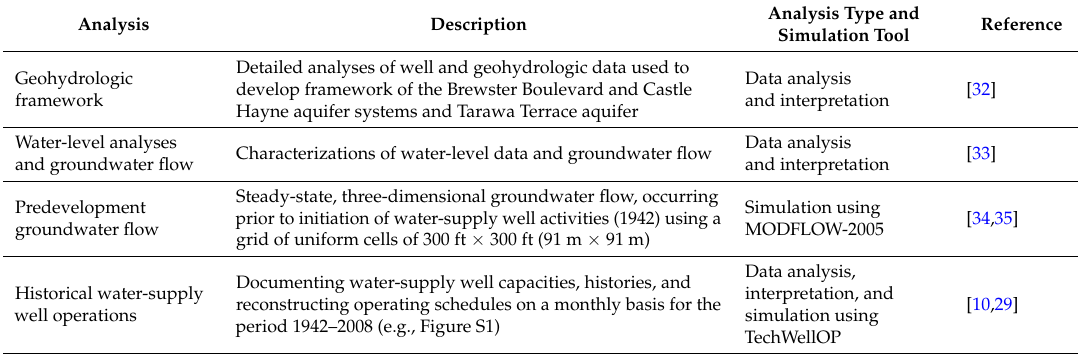
Table 1. Analyses and simulation tools used to reconstruct historical drinking-water concentrations